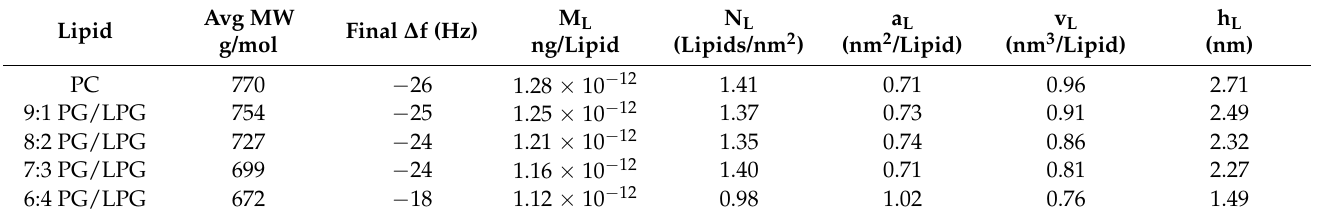
Table 4. Calculated values for lipid area per molecule and bilayer hydrophobic region